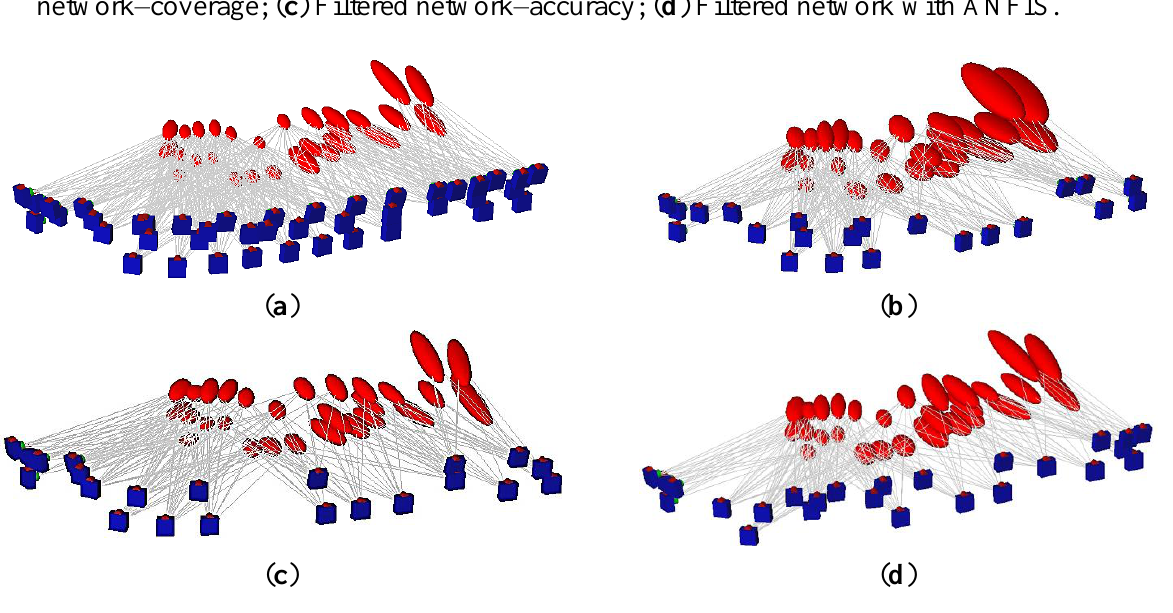
Figure 17. The error ellipsoids of the checkpoints. ( a ) Dense network; ( b ) Filtered